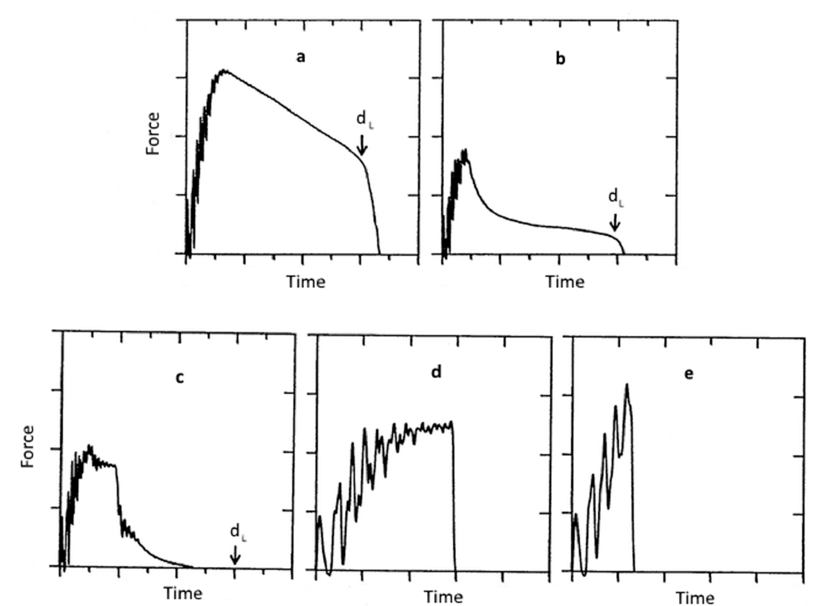
Figure 8. Types of failure modes in impact tests: ( a ) no break: yielding followed by plastic deformation till deflection limit d L ; ( b ) partial break: additional yielding and stable crack growth till deflection limit d L ; ( c ) tough break: yielding and stable crack growth till total failure; ( d ) brittle break: yielding followed by unstable crack growth; ( e ) splintering break: unstable cracking followed by yielding.